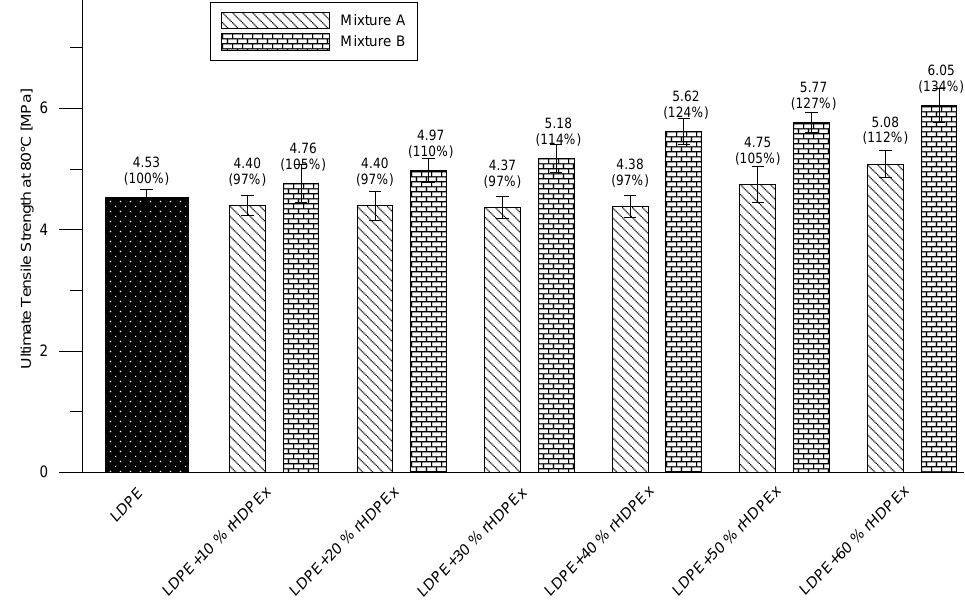
Figure 7. Ultimate tensile strength at elevated temperature—Mixtures A and B.